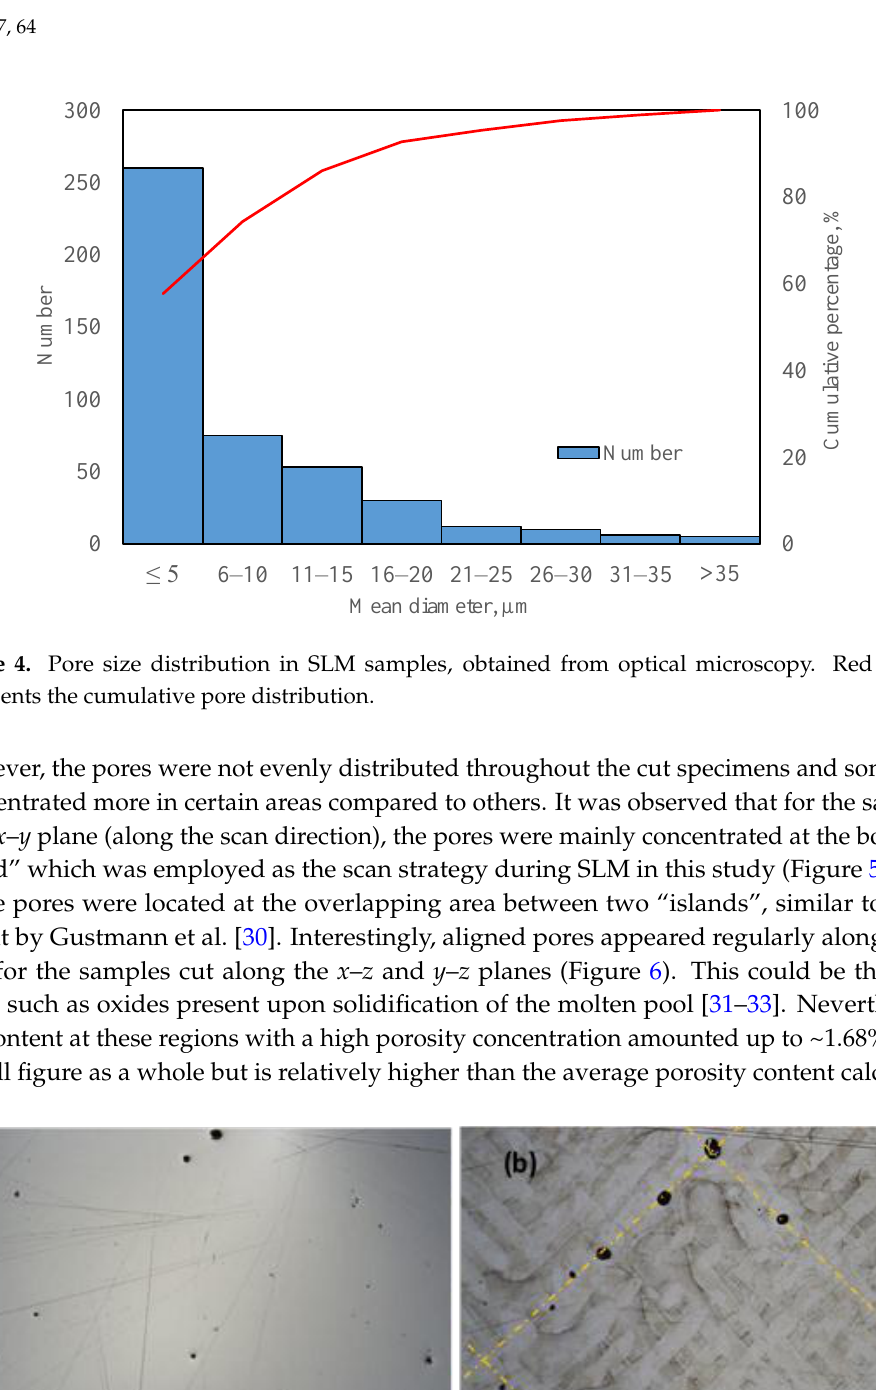
Figure 5. Micrographs showing porosity distribution for the ( a ) un-etched and ( b ) etched specimen cut along the x – y plane.